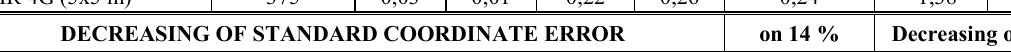
Table 4. Decreasing of standard coordinate error with better DTM